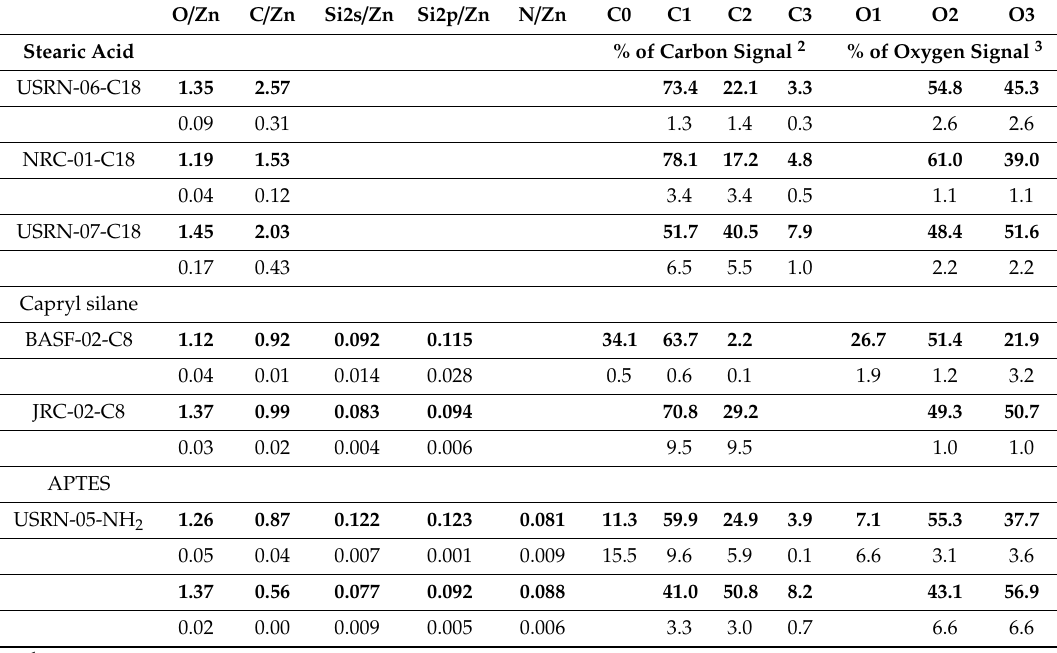
Table 4. Relative atomic compositions obtained from quantitative analysis of XPS data 1 for surface-modified ZnO